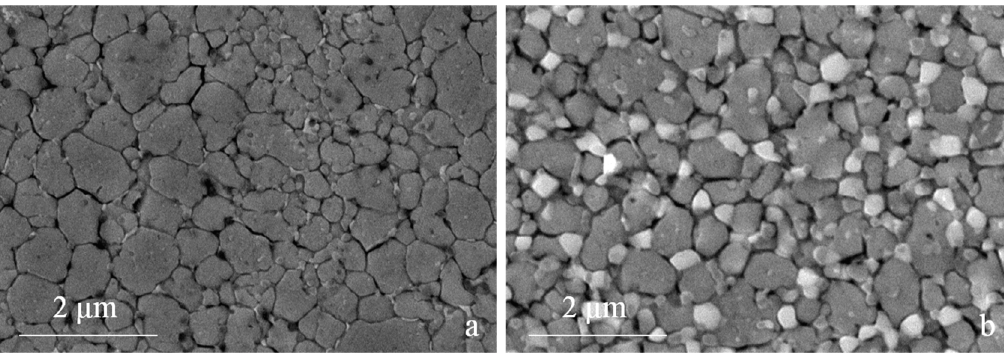
Figure 8. Microstructure of the two base MM steels ( a ) H13; ( b ) M3:2.